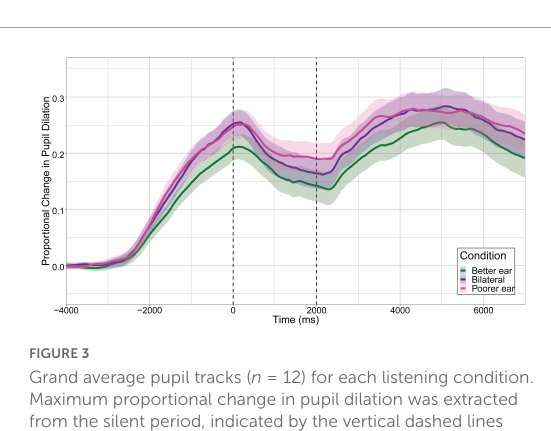
FIGURE3 Grand average pupil tracks ( n = 12) for each listening condition. Maximum proportional change in pupil dilation was extracted from the silent period, indicated by the vertical dashed lines (0–2,000 ms). Shaded regions represent ± 1.96 SE (95% confidence interval).